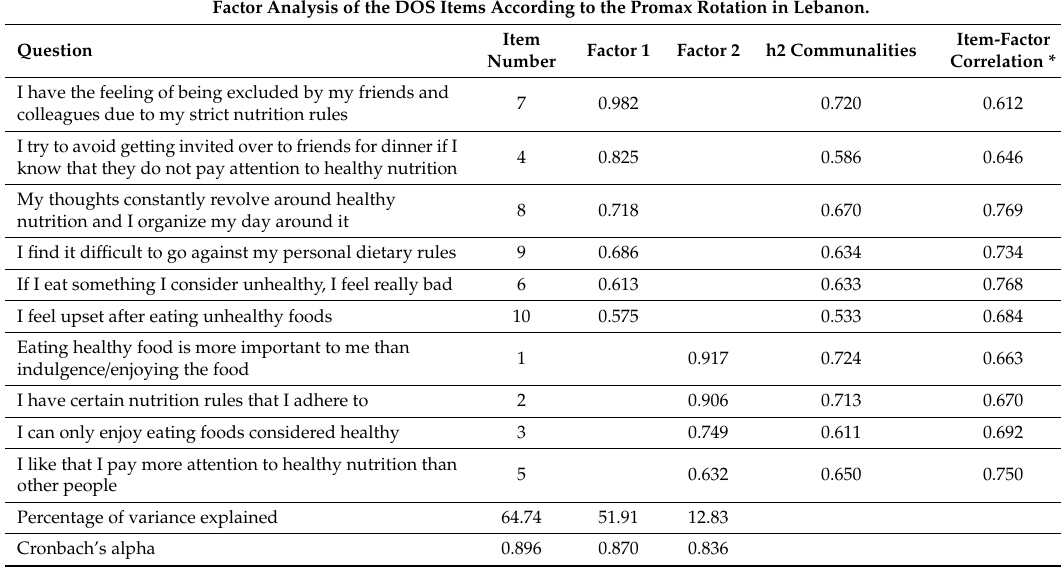
Table 2. Factor analysis of the Düsseldorf Orthorexia Scale (DOS) items in a Lebanese Sample. Factor Analysis of the DOS Items According to the Promax Rotation in